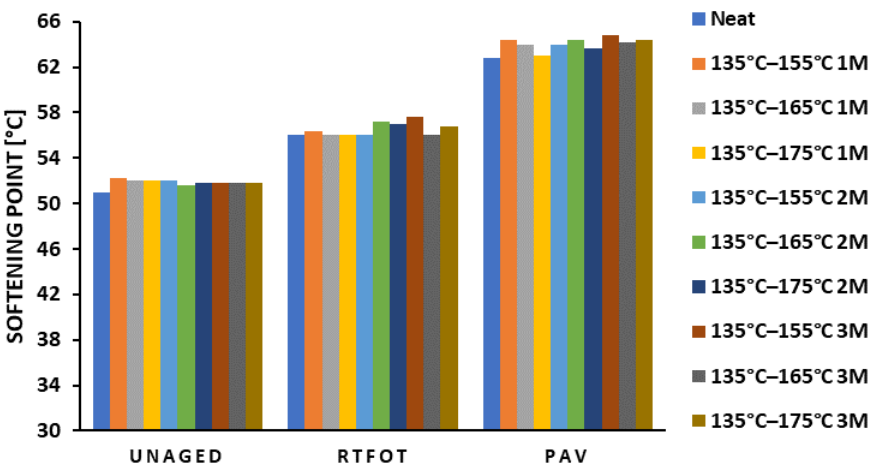
Figure 15. Softening point results of all samples at every aging stage.